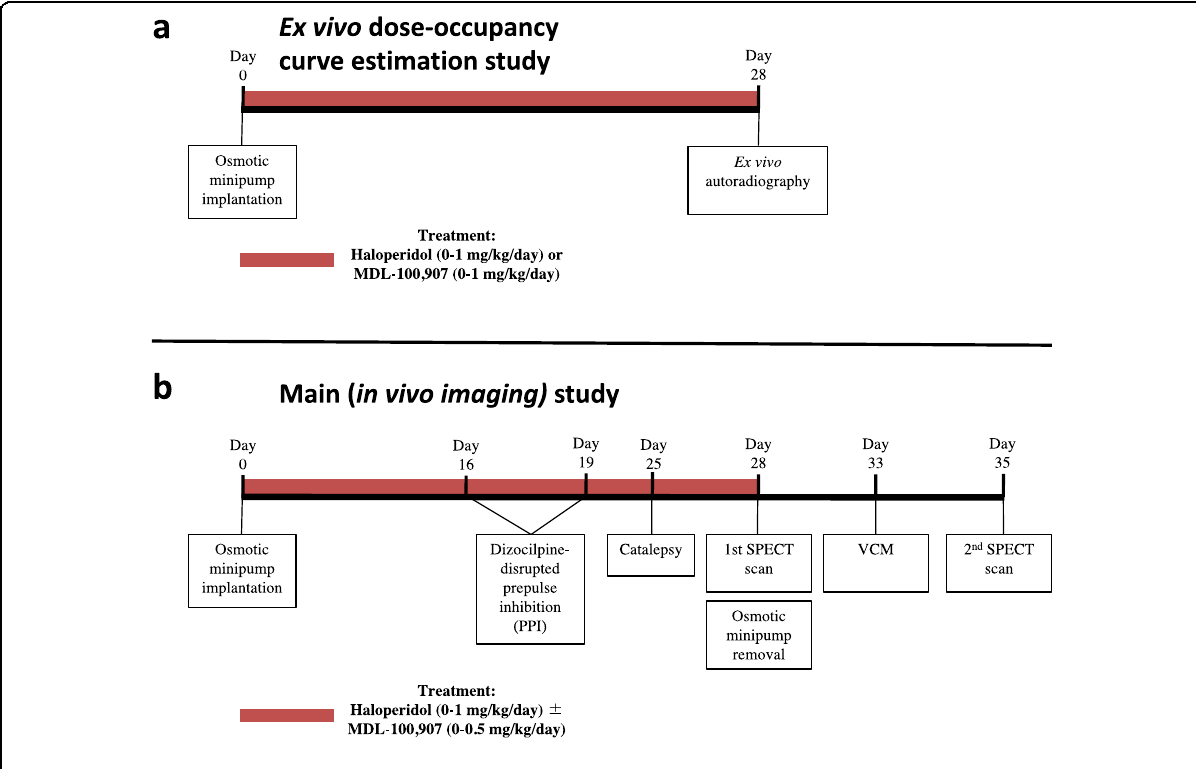
Fig. 1 Graphical presentation of the timeline of the present study. The black line represents the timeline of the experiments with the various time-points (in days) noted above the line. The red line represents the period during which the animals were under treatment. The square boxes below the black line describe the behavioral and/or imaging experiments undetaken at speci fi c